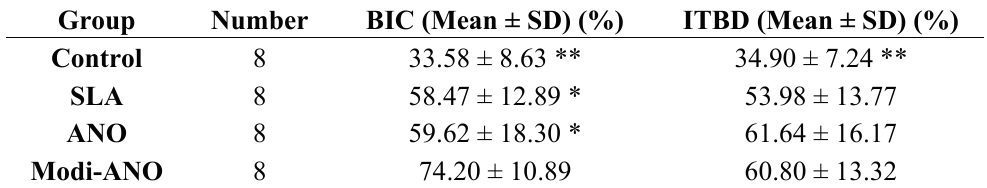
Table 3. BIC and ITBC values of the four surface treatment